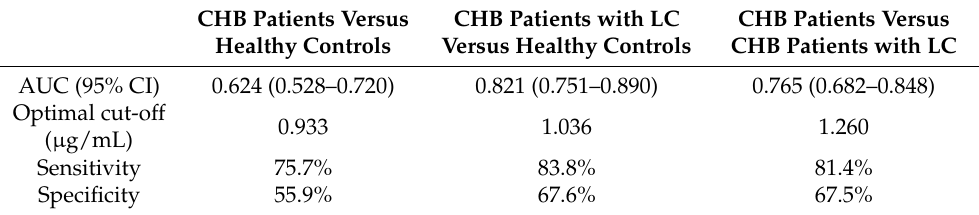
Table 5. Diagnostic performance of serum AsAGP levels through the mutual comparison of healthy controls, CHB patients, and CHB patients with LC.